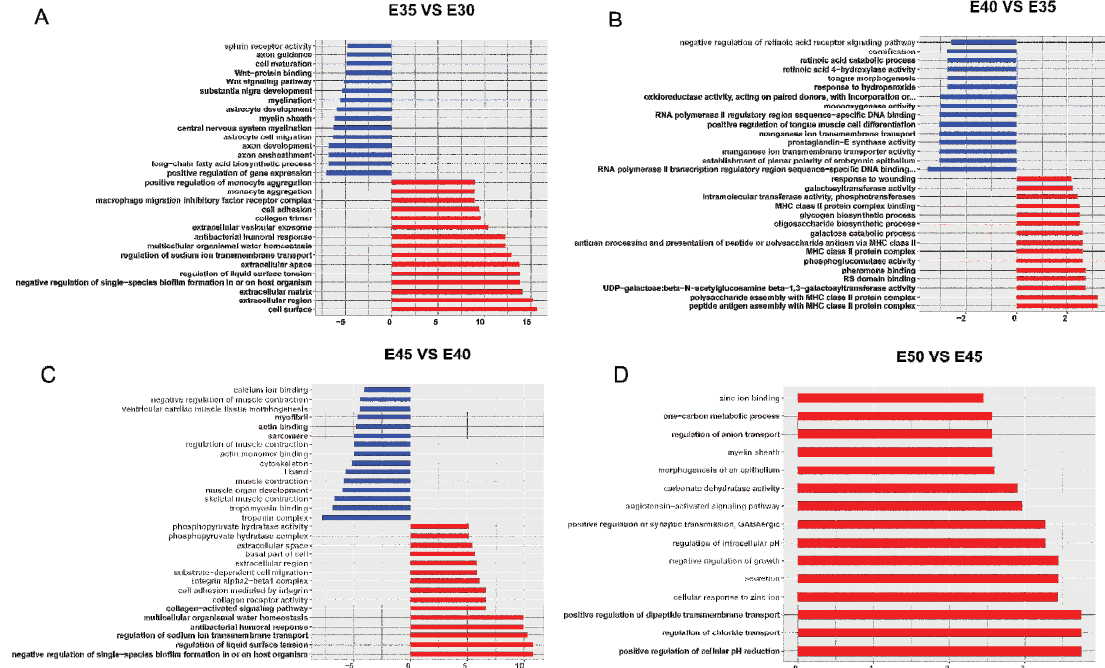
Figure 3. The significant gene ontology (GO) terms of differentially expressed genes during secondary palate development. ( A ) The significantly enriched GO terms between E35VSE30; ( B ) The significantly enriched GO terms between E40VSE35; ( C ) The significantly enriched GO terms between E45VSE40; ( D ) The significantly enriched GO terms between E50VSE45. The y axis showed the GO terms and the x axis showed the negative logarithm of the p value ( − LgP). A larger − LgP indicated a smaller p value for the difference.